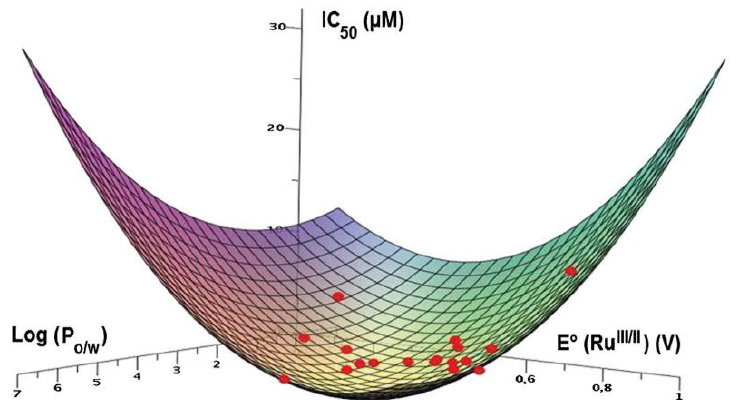
Figure 29. Three-dimensional representation of the correlation between IC 50 , the redox potential (E° RuIII/II ) and the lipophilicity (logP o/w ). (Reprinted with permission from ref. [118]. Copyright 2011 Royal Society of Chemistry). 2011 Royal Society of